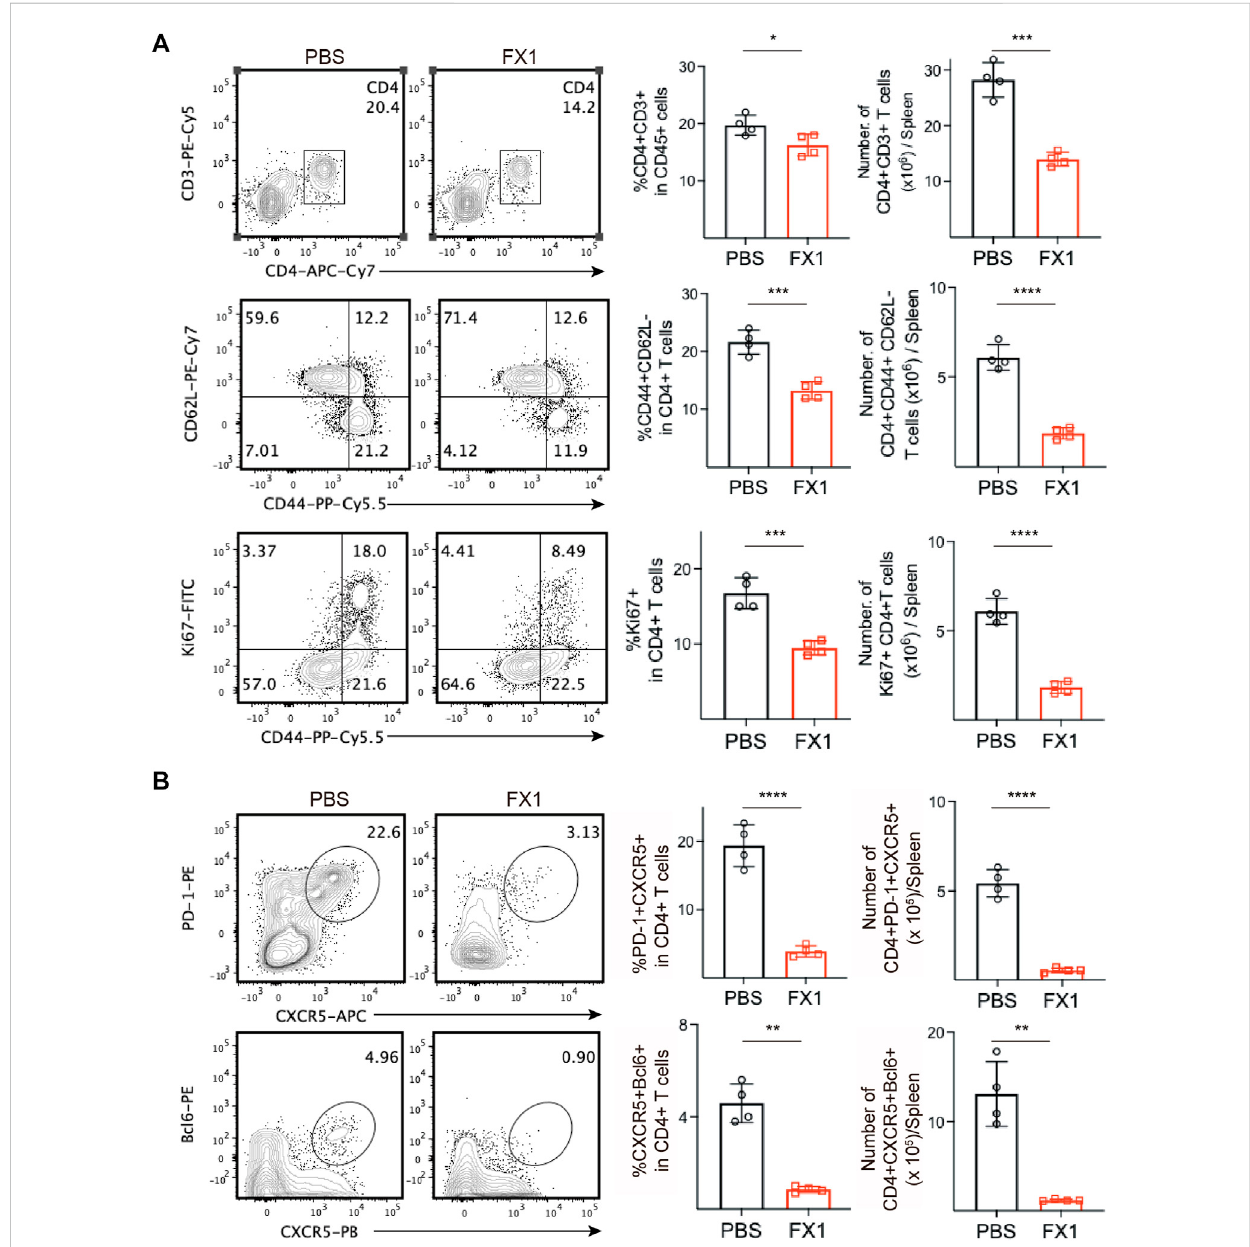
FIGURE 5 FX1 inhibits T follicular helper cell expansion during chronic cardiac transplant rejection in mice (A) . The spleens were obtained from the recipient miceonpostoperativeday28andweregroundintosingle-cellsuspensionsforFCMdetection.Thecontourplotsdemonstratetheratiosofcharacteristic CD3 + CD4 + Tcells,CD44 + CD62L-Tcells,andCD44+Ki67 +Tcellsinbothgroups,whilethebarcharts( n =4)illustratetheratiosbetweenthetwogroups (B) .Thecontourplots demonstrate theratiosofcharacteristicPD1+CXCR5+TfhandBCL6+CXCR5+ Tfhinbothgroups,while thebarcharts( n =4) illustrate the ratios of Tfh cells between the two groups. Error bars represent SD. ns, not signi fi cant, * p < 0.05, ** p < 0.01, *** p < 0.001, **** p <